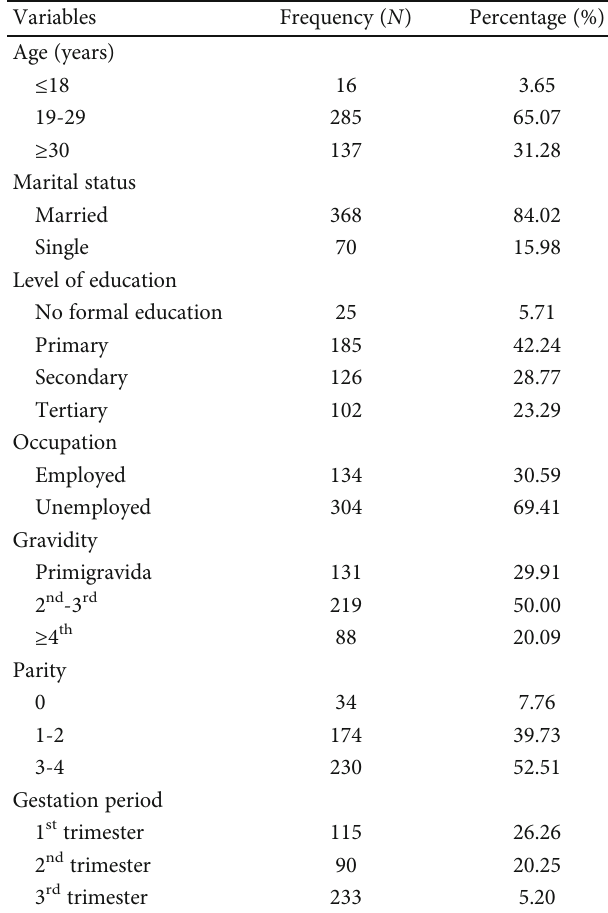
Table 1: Sociodemographic and obstetric characteristics of participants ( n = 438